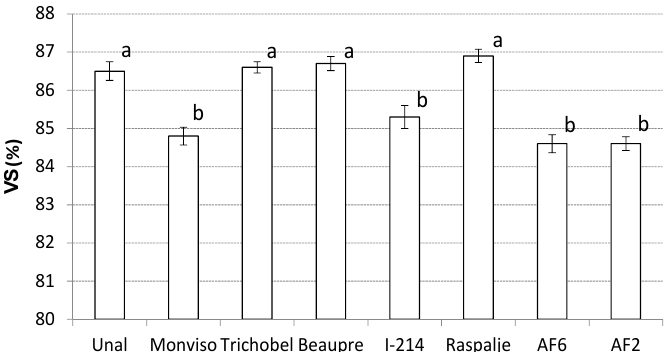
Figure 4. Relationship between ash content (%) and basal diameter (mm) for eight poplar genotypes. Black dots represent group 1: Beaupré, Raspalje. Grey dots represent group 2: Trichobel, AF6, Unal. White dots represent group 3: I-214, Monviso, AF2.